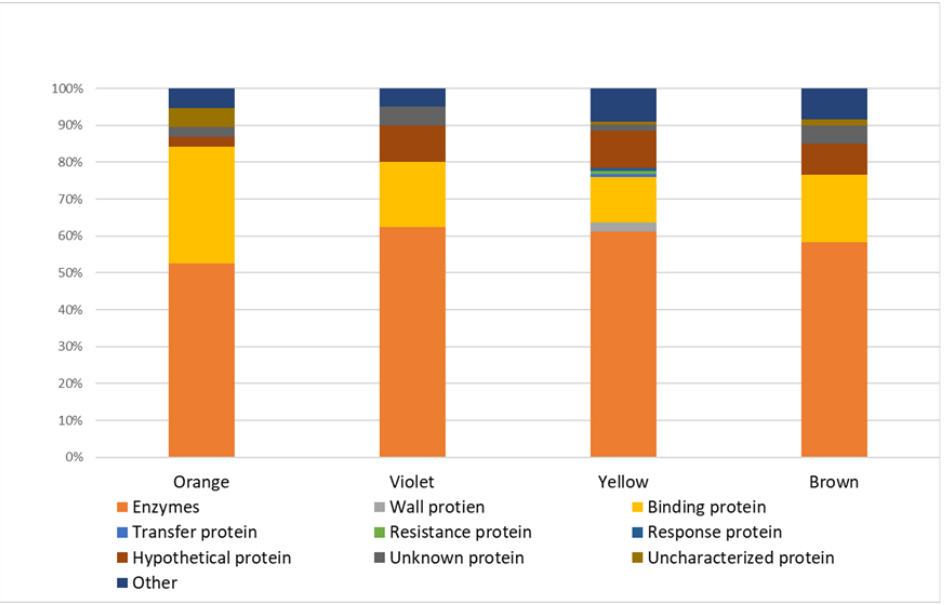
Figure 1. The percentage of identified proteins with a specific function in bee pollen of a given color. The number of proteins identified depended on the color of the bee pollen samples. The highest number of proteins (n = 121; 47% of all Viridiplantae proteins) was identified in samples of yellow pollen. In samples of brown bee pollen, 60 proteins were identified (standing for 23% of identified Viridiplantae proteins). The number of proteins reliably identified in violet and orange bee pollen samples was n = 40 and n = 38 (≈15% of Viridiplante proteins), respectively (Figure 2).